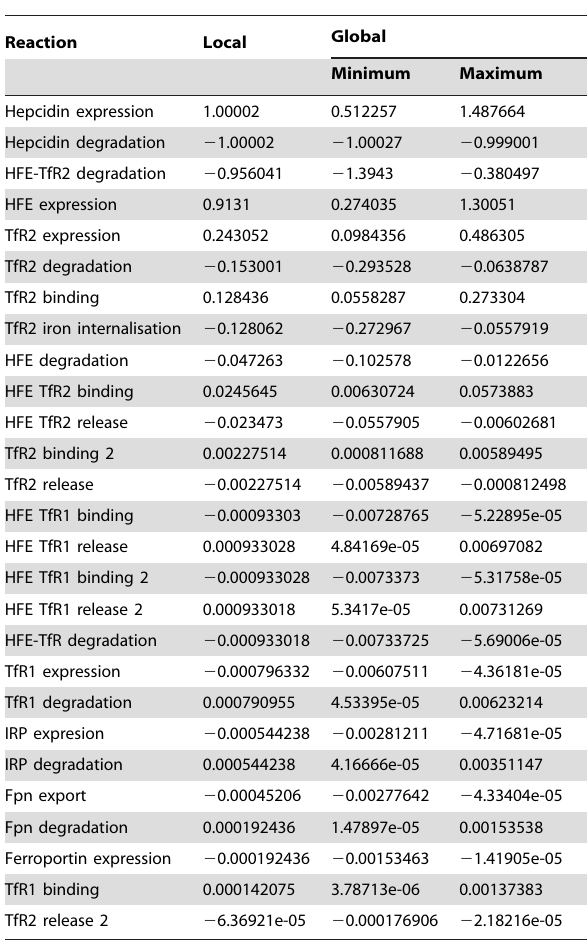
Table 6. Metabolic control analysis—Concentration control coefficients for hepcidin.